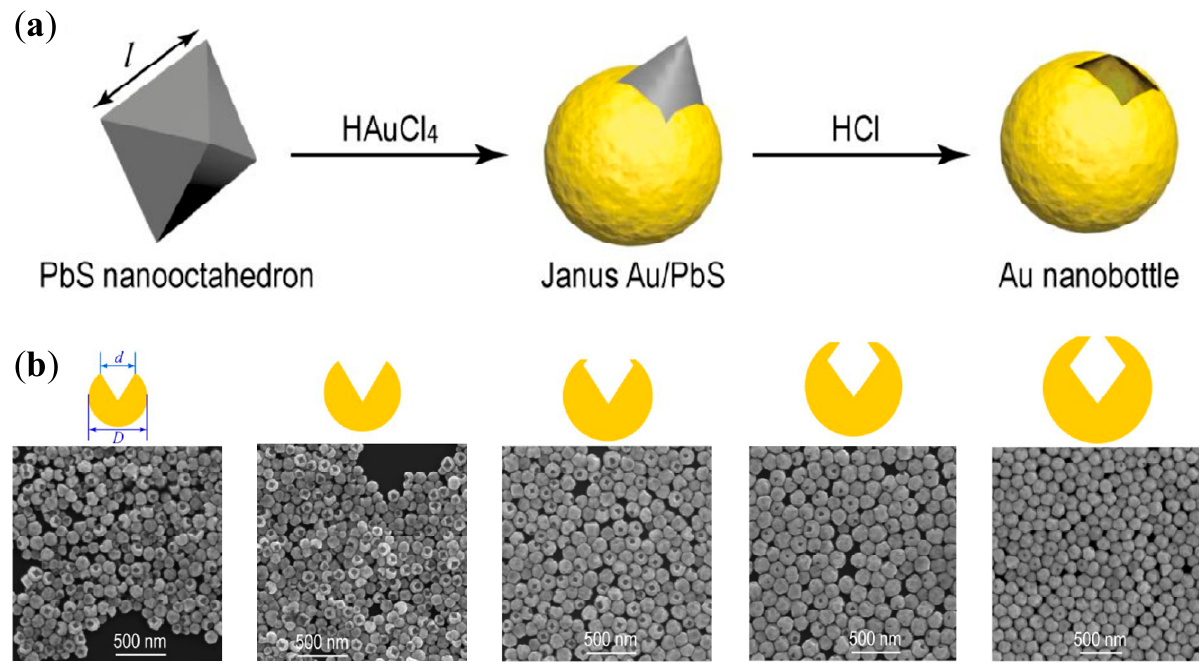
Figure 7. ( a ) The growth process of Au nanobottle. ( b ) The change in opening size ( d ) and the diameter ( D ) of Au nanobottle. The scale bar is 500 nm. Reprinted with permission from Ref. [40]. Copyright 2019, copyright American Chemical Society.